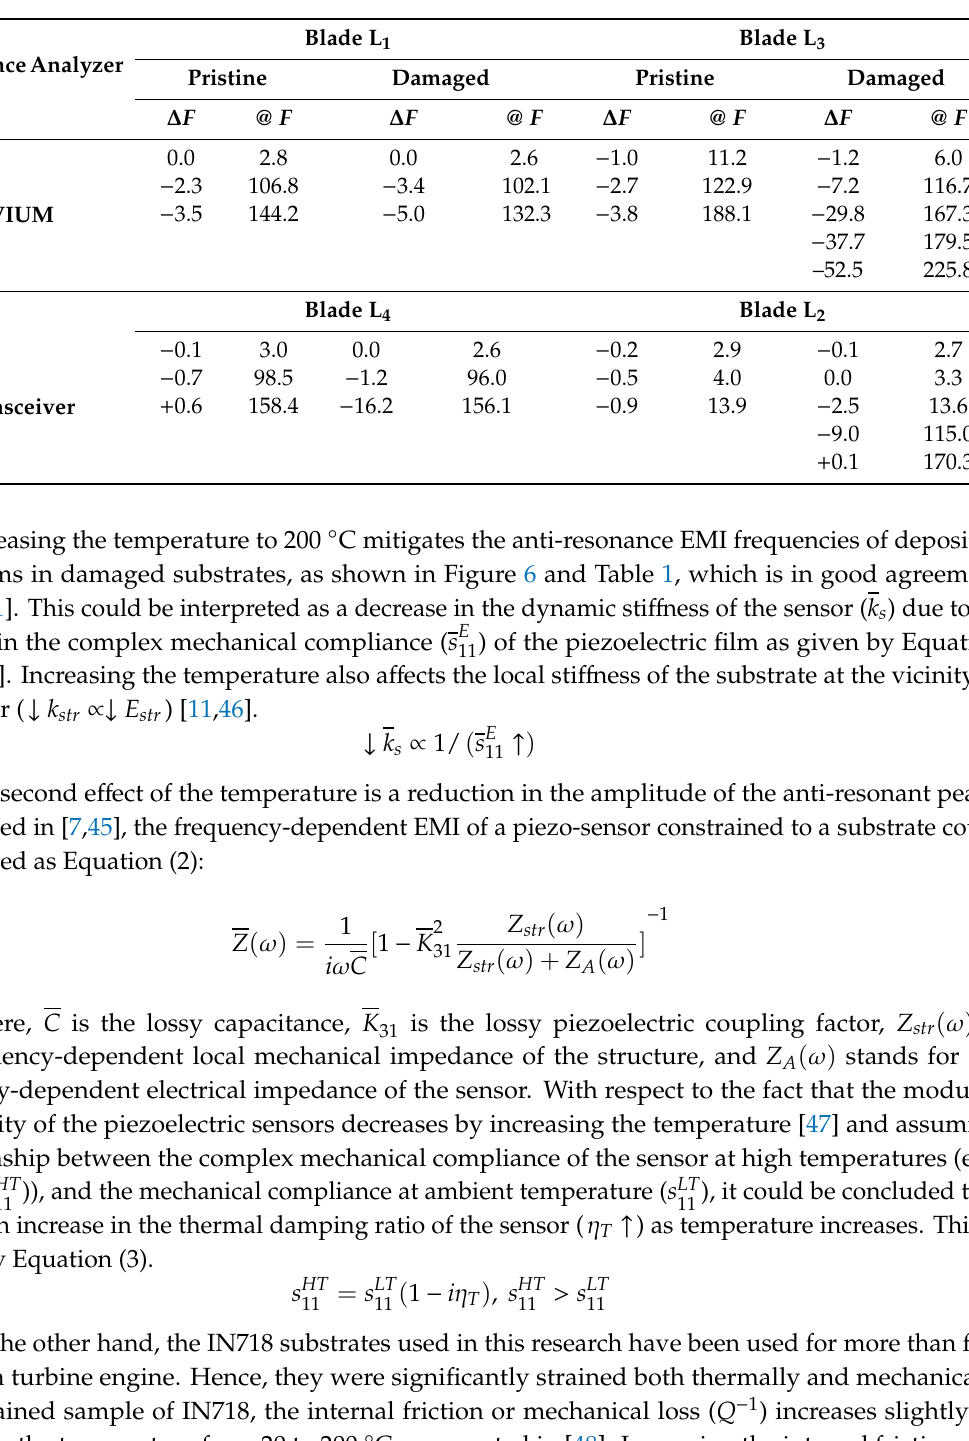
Table 3. EMI frequency shift of the pristine and damaged blades at 200 ◦ C compared to ambient temperature, using IVIUM and the transceiver